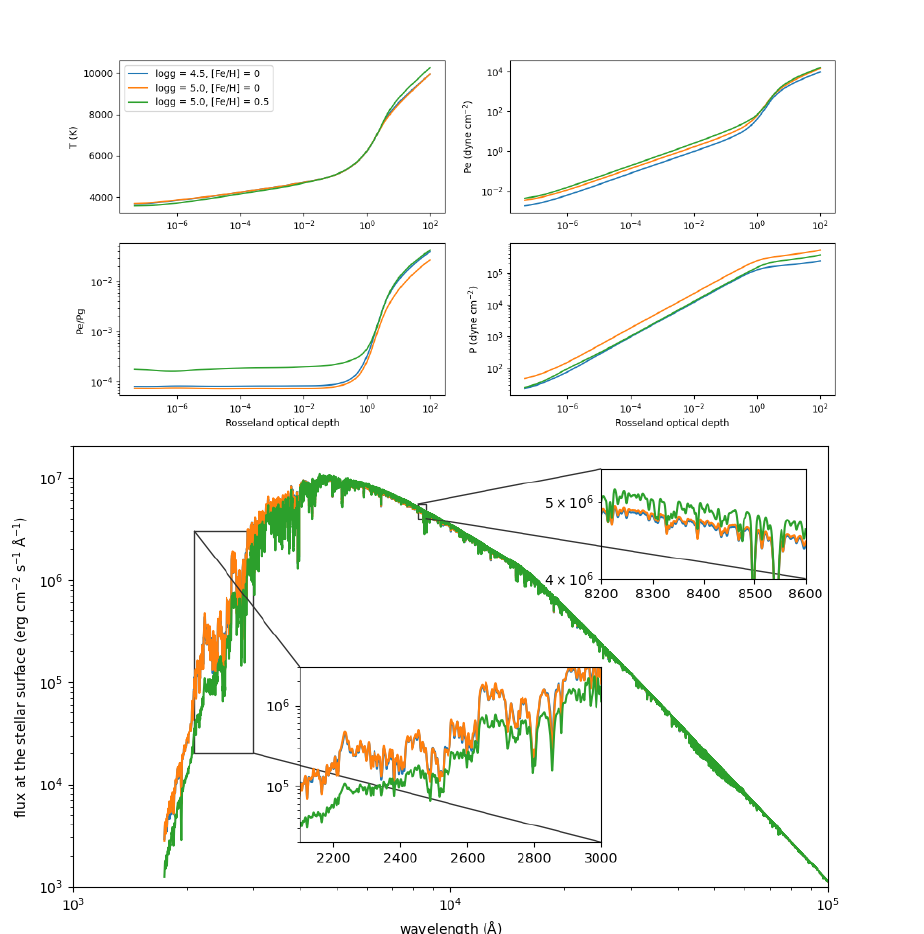
Figure 7. ( Upper panel ) Run of various thermodynamical quantities (clockwise: temperature, elec- tron pressure ( Pe ), gas pressure ( P ) and their ratio ( Pe / P )) with the Rosseland mean opacity for model atmospheres for a solar-like star ( T eff = 5777 K). ( Lower panel ) Predicted emergent flux at the atmospheric surface for the models in the upper panels (no scaling is necessary, since we are only comparing